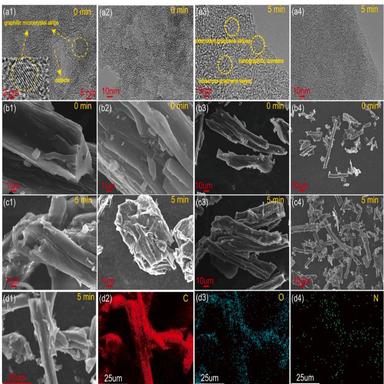
a1-a2) HRTEM images of HC, a3-a4) HRTEM images of NHC-5, b1-b4) TEM images of HC, c1-c4) TEM images of NHC-5, and d1-d4) the corresponding EDS mapping of NHC-5.